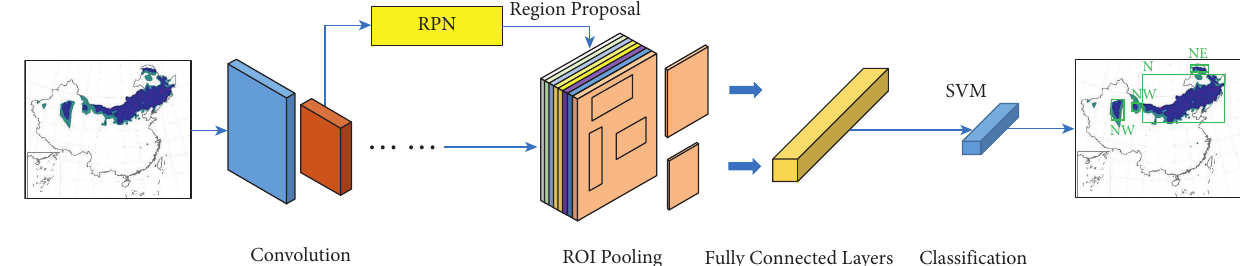
Figure 4: The architecture of the proposed Faster R-CNN and SVM